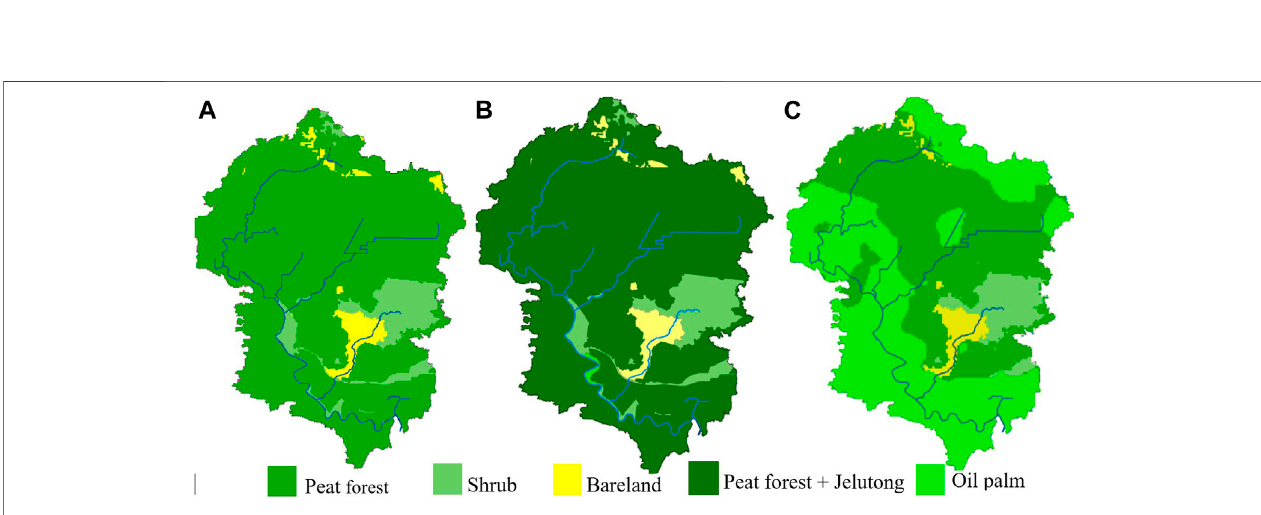
FIGURE 2 | Schematic land-use type in (A) Scenario 1, (B) Scenario 2), and (C) Scenario